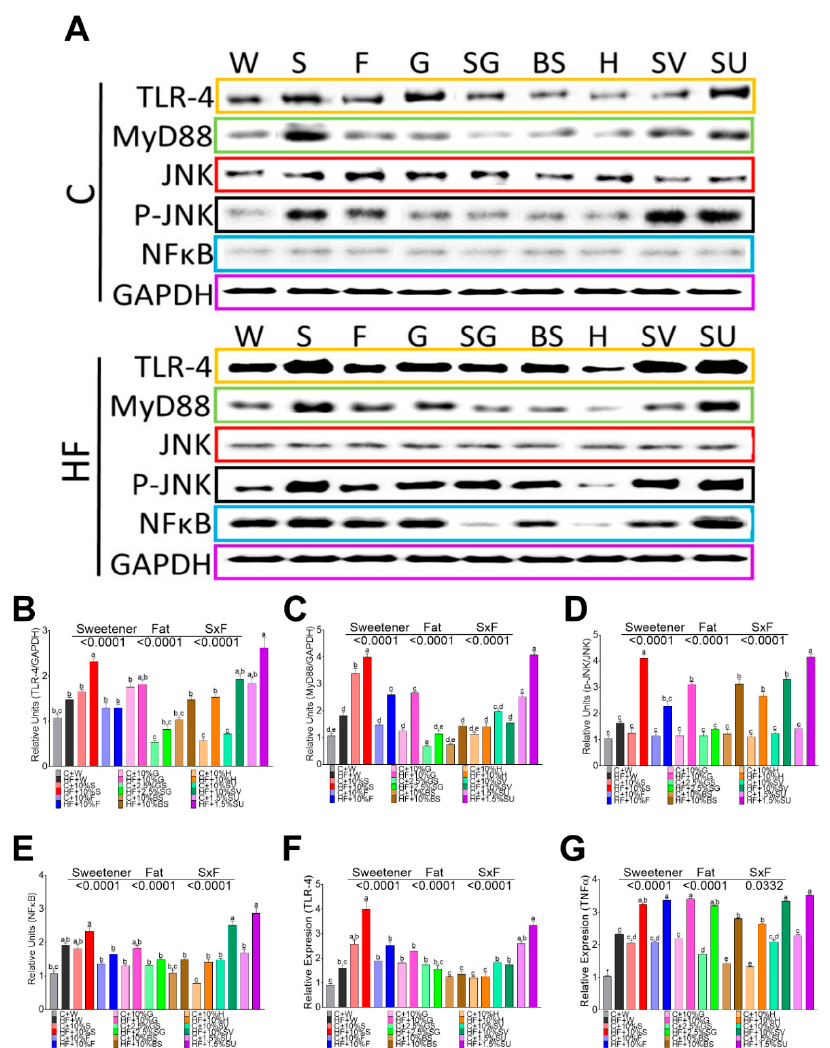
Figure 2. Relative protein abundance and gene expression of inflammation markers in white adipose tissue of rats fed di ff erent sweeteners with and without high fat diet ( A ); protein abundance of toll like receptor 4 (TLR-4) ( B ), myeloid di ff erentiation factor 88 (MyD88) ( C ); c-Jun N- terminal kinase (JNK) ( D ); Nuclear Factor kappa-light-chain-enhancer of activated B cells (NF κ B) ( E ); Relative expression of TLR4 ( F ) and tumor necrosis factor alpha (TNF α )( G ). The data are expressed as the mean ± SEM ( n = 6). Results were considered statistically significant at p < 0.05. Significant di ff erences among groups are indicated by letters, where a > b > c > d >